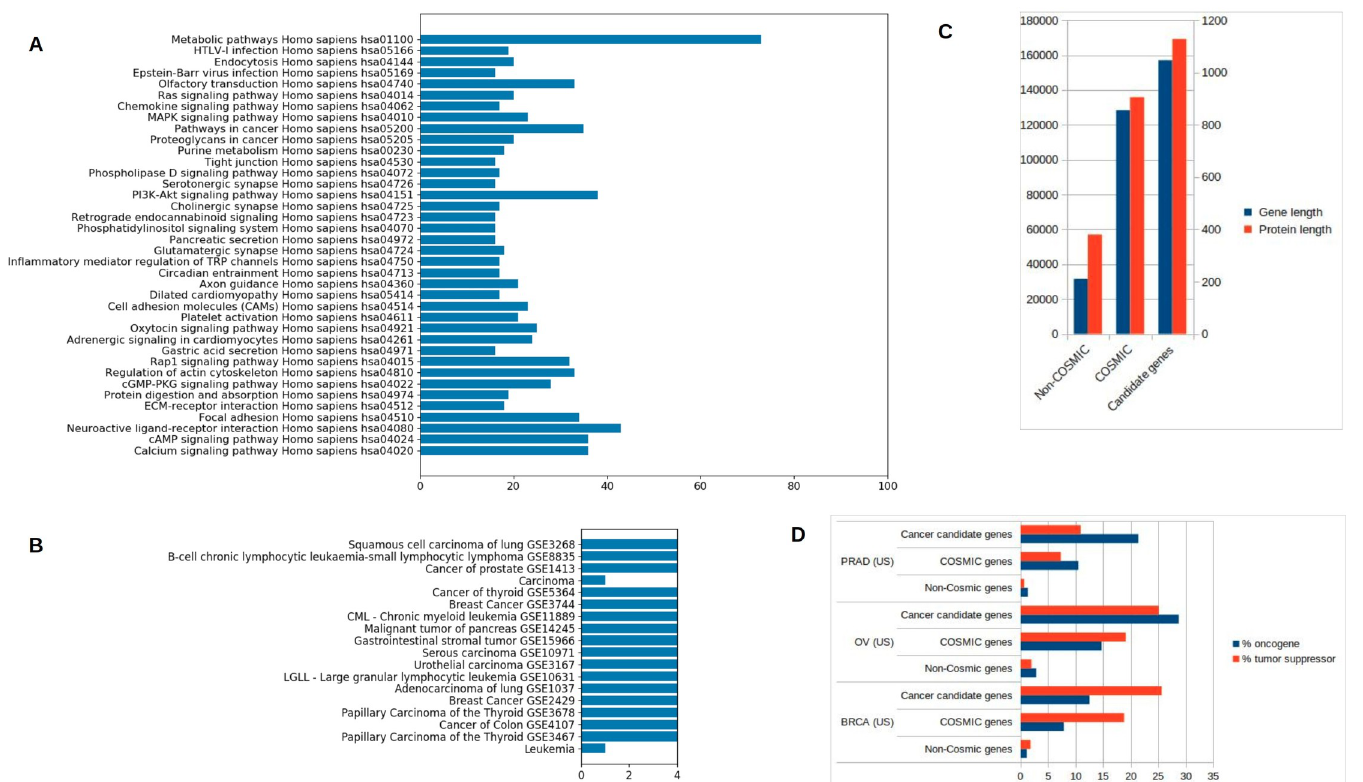
Fig 3. Gene set enrichment & sequences analysis. a) KEGG pathway enrichment for candidate genes, showing the number of genes with specific enrichment for the most enriched pathways; b) Disease signature enrichment showing gene enrichment in cancer-related conditions. c) Gene and protein length comparison between the candidate genes, COSMIC genes and non-COSMIC genes (Gene-length K-S test p-values: candidate vs. non-cancer genes = 0.0, COSMIC vs. non-cancer genes < 0.001; Protein-length p-values: candidate vs. non-cancer genes = 0.0, COSMIC vs. non-cancer genes < 0.001), d) Percentage of oncogenes (blue) and tumor suppressors (red), as defined by the 20/20 rule [3], in the different gene groups within each cancer type (Chi-square tests of results for candidate-genes vs non-COSMIC genes, and COSMIC genes vs non-COSMIC genes: all p-values < 0.001 for all cancer types for both oncogene and tumor-suppressor classifications).